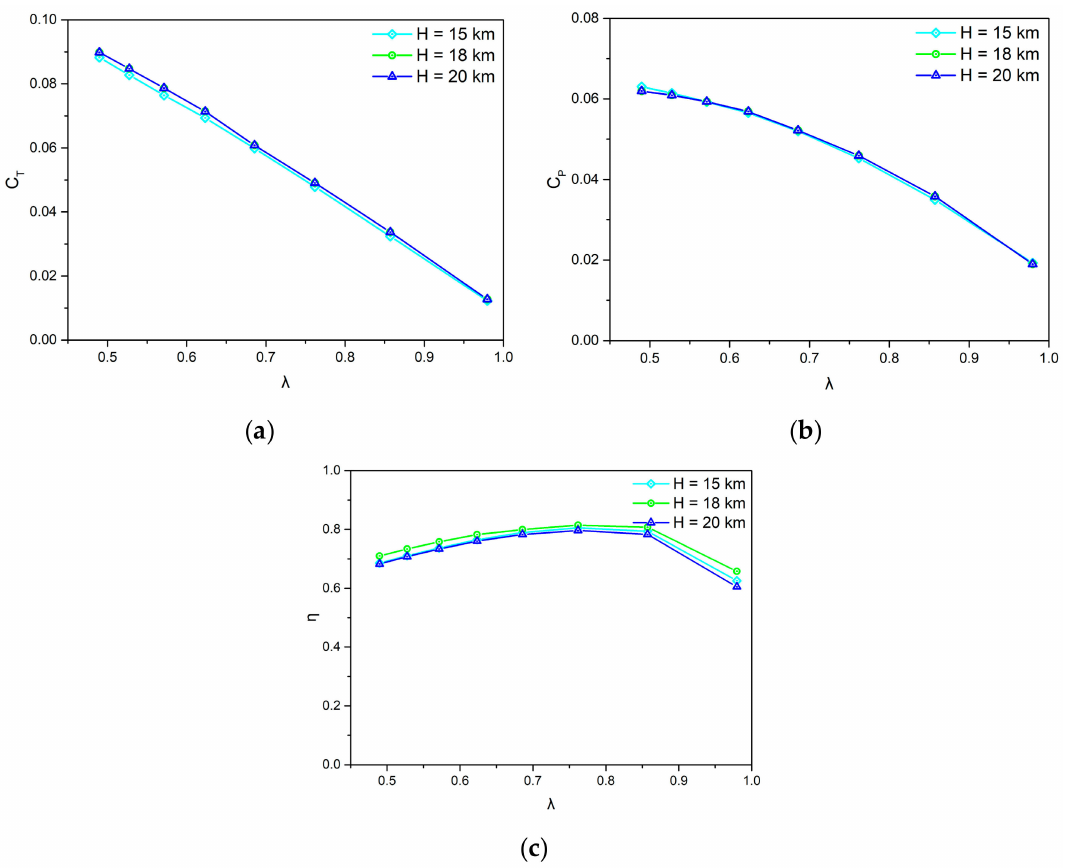
Figure 16. Propeller performance at different altitudes: ( a ) thrust coefficient; ( b ) power coefficient; ( c ) efficacy.